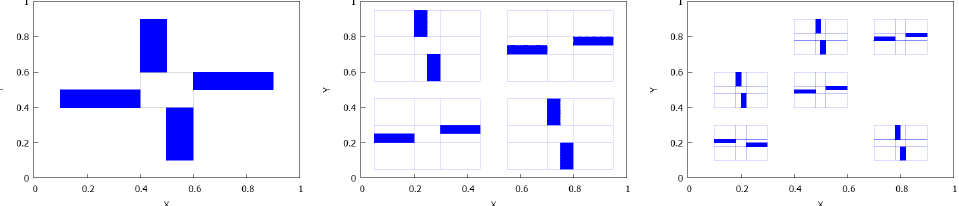
Figure 13. A mixing and B no mixing. Distribution D6. In the first examples, p = 2, q = 1, and p = 4, q = 2; in the last one, p = 6, q =